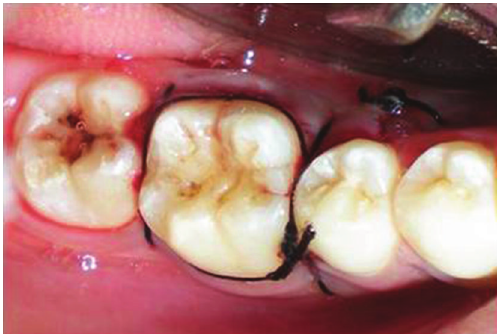
Figure 14: Clinical view after the fragment attachment has been performed, and flaps have been sutured.